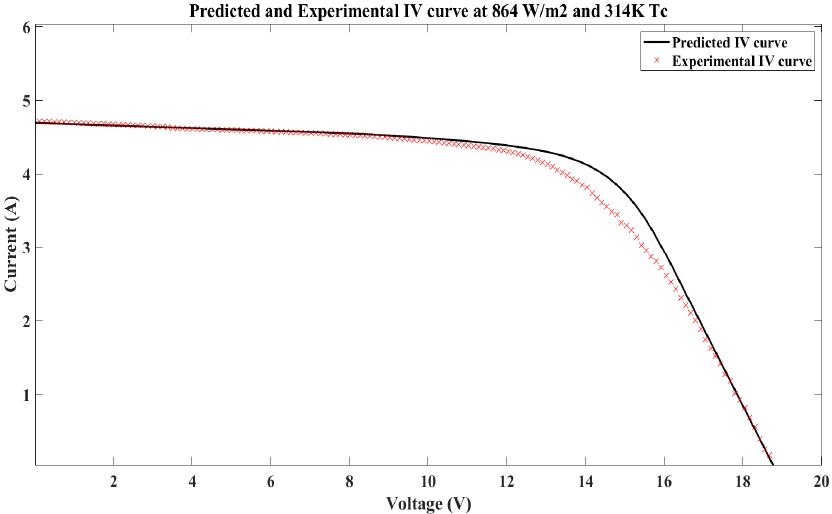
Figure 9. Predicted and experimental IV curves for flexible mono-module at 864 W/m 2 and 314K Tc.